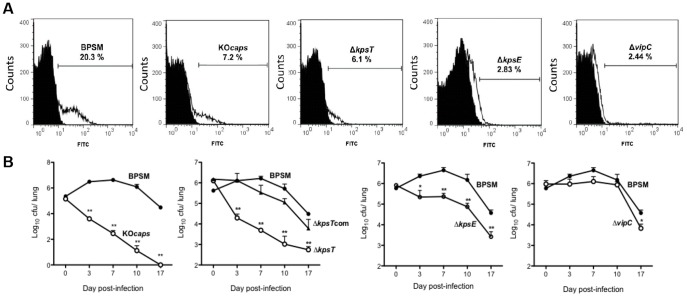
Phenotypic characterization of the ΔkpsT, ΔkpsE and ΔvipC mutants.(A) Detection of the polysaccharide capsule at the bacterial surface. Mouse polyclonal anti-Salmonella typhi Vi antigen immune serum was co-incubated with non-permeabilized BPSM, KOcaps, ΔkpsT, ΔkpsE and ΔvipC bacteria strains as indicated in each flow cytometry plot. All bacteria strains were grown in Bvg- phase. Anti-mouse FITC-conjugated IgG was used as secondary antibody. Isotype-matched controls are incubated with an anti-mouse antibody as shown in black histogram. The fluorescent cells were detected by flow cytometry, with 20,000 events counted for each sample. A representative experiment is shown from three independent experiments, with percentage of fluorescent cells indicated in each panel. (B) Lung colonization profiles. Balb/C mice were infected intranasally with 5×105 CFU of B. pertussis BPSM, KOcaps, ΔkpsT, ΔkpsTcom, ΔkpsE and ΔvipC as indicated at each of graph plot. At the indicated time points, four infected mice per group were euthanized and their lungs were harvested, homogenized and plated on blood agar to determine the total number of CFU per lung. The results are expressed as the mean ± SEM of four mice per group. ** p value<0.01 and * p value<0.05 relative to BPSM. Results are representative of two independent experiments.